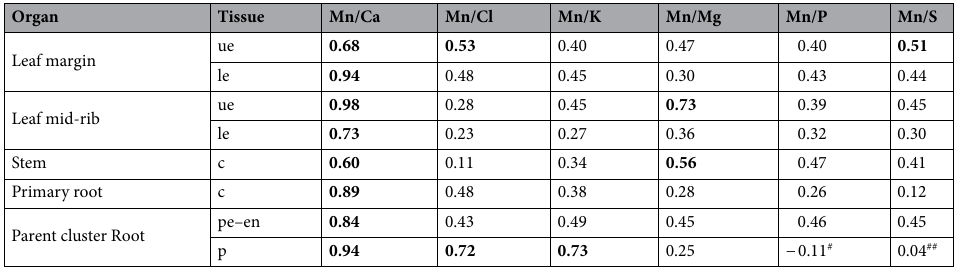
Table 3. Pearson correlation coefficients between Mn and other physiological elements among the main Mn sinks of the different organs of Grevillea meisneri ( ue upper epidermis, le lower epidermis, c cortex, pe–en pericycle–endodermis layers, p phloem). P-values are all ≤ 0.0001, except where otherwise indicated. Values of Pearson correlation coefficient higher than 0.5 are indicated in bold characters. # P -value: 0.0007. ## P -value: